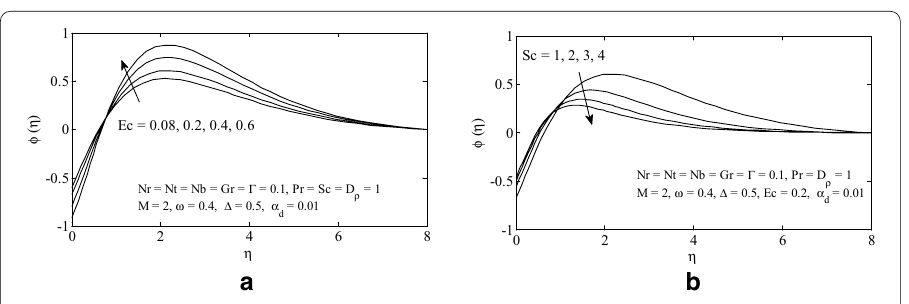
Fig. 9 a , b Impact of Ec and Sc on concentration profile